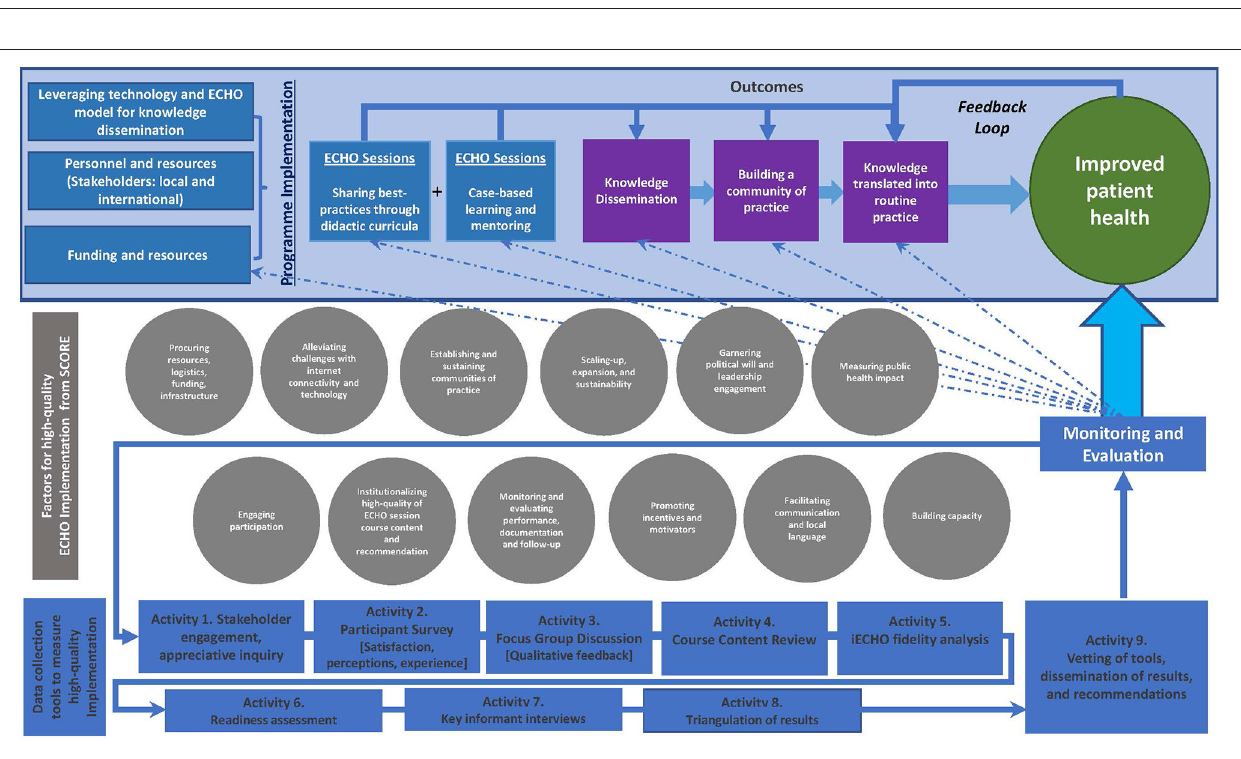
FIGURE 2 | Proposed Comprehensive Evaluation Framework with evaluation